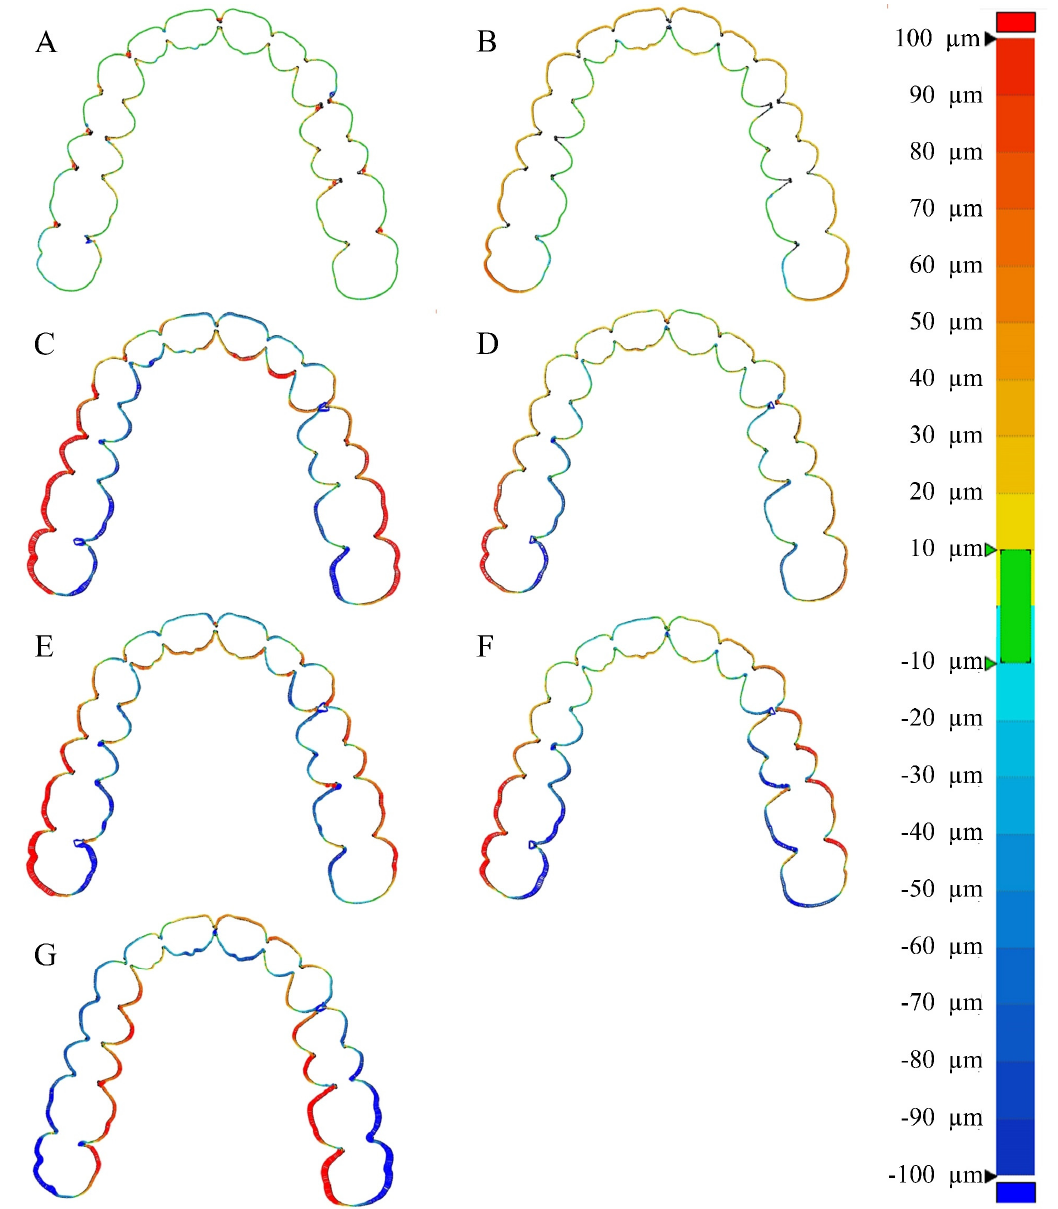
Figure 7. Comparison of the color map of horizontal displacement according to the 3D scanners. ( A ) 3Shape E1, ( B ) DOF, ( C ) CS3500, ( D ) CS3600, ( E ) Trios2, ( F ) Trios3, and ( G ) i500.